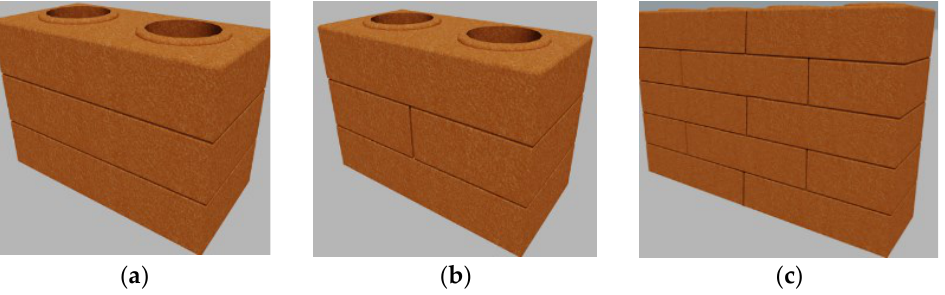
Figure 4. Prism models and small wall studied: ( a ) 3ISA Prism; ( b ) 3MSA Prism; ( c ) Small Wall (PPSA).